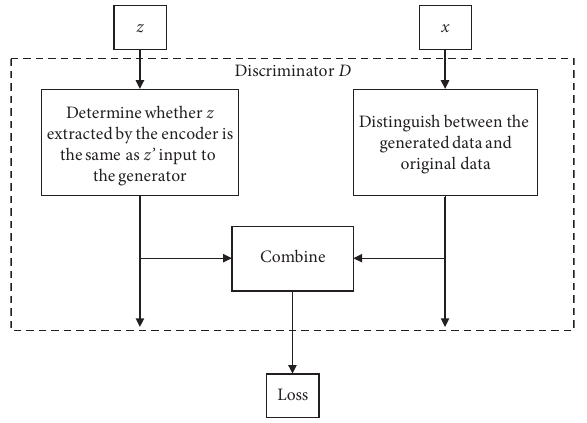
Figure 1: The structure of